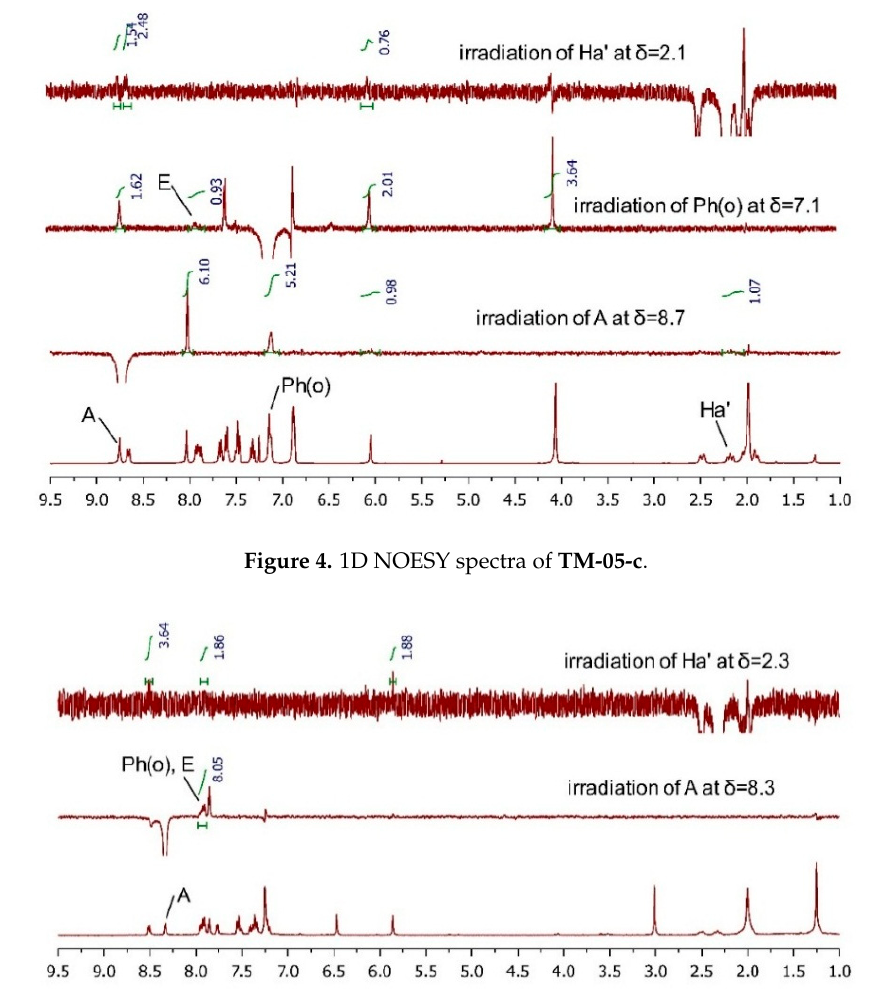
Figure 5. 1D NOESY spectra of TM-05-d . Table 1. Proton chemical shifts and coupling constants in CDCl 3 of TM-05-c and TM-05-d